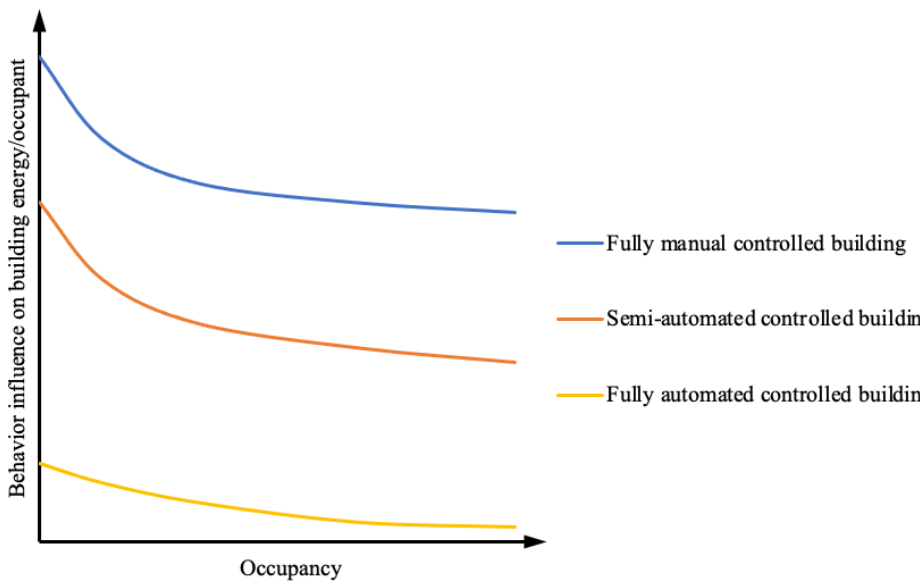
Figure 2. Influences of occupant behavior on building energy per occupant with occupancy under different building automation levels [4].